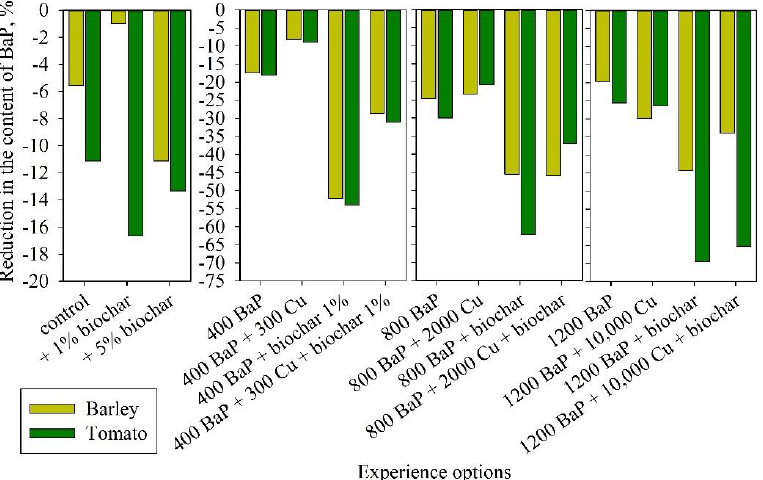
Figure 3. BaP content decreasing in the soil of different experiment variants after the second season of plant vegetation. of plant